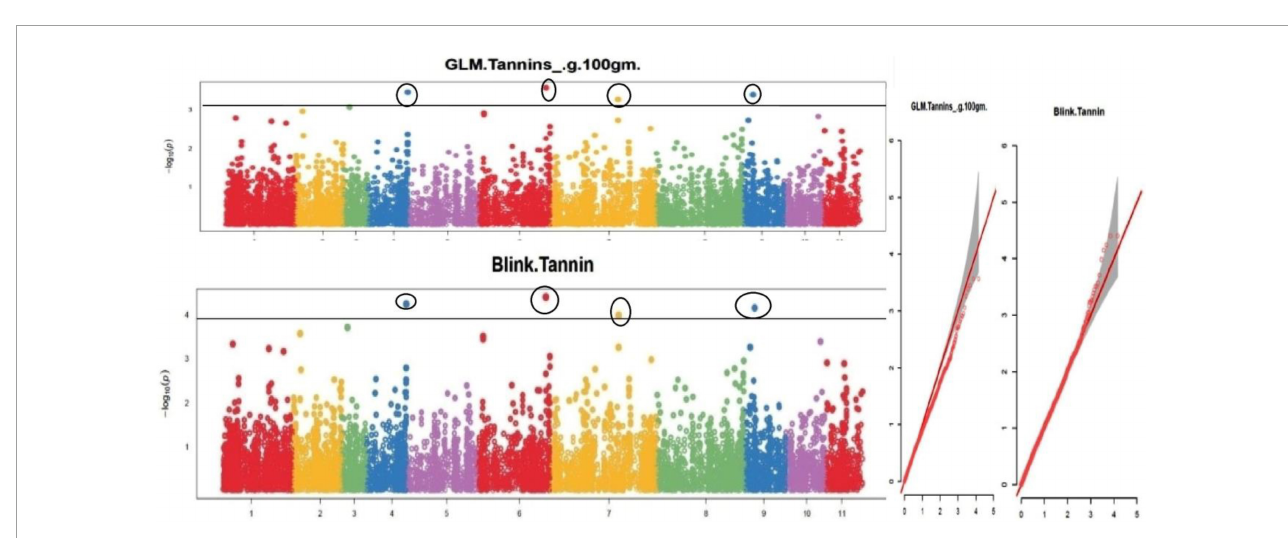
FIGURE9 Manhattan plots and Quantile-Quantile plots depicting the significant association of SNP markers with grain tannin